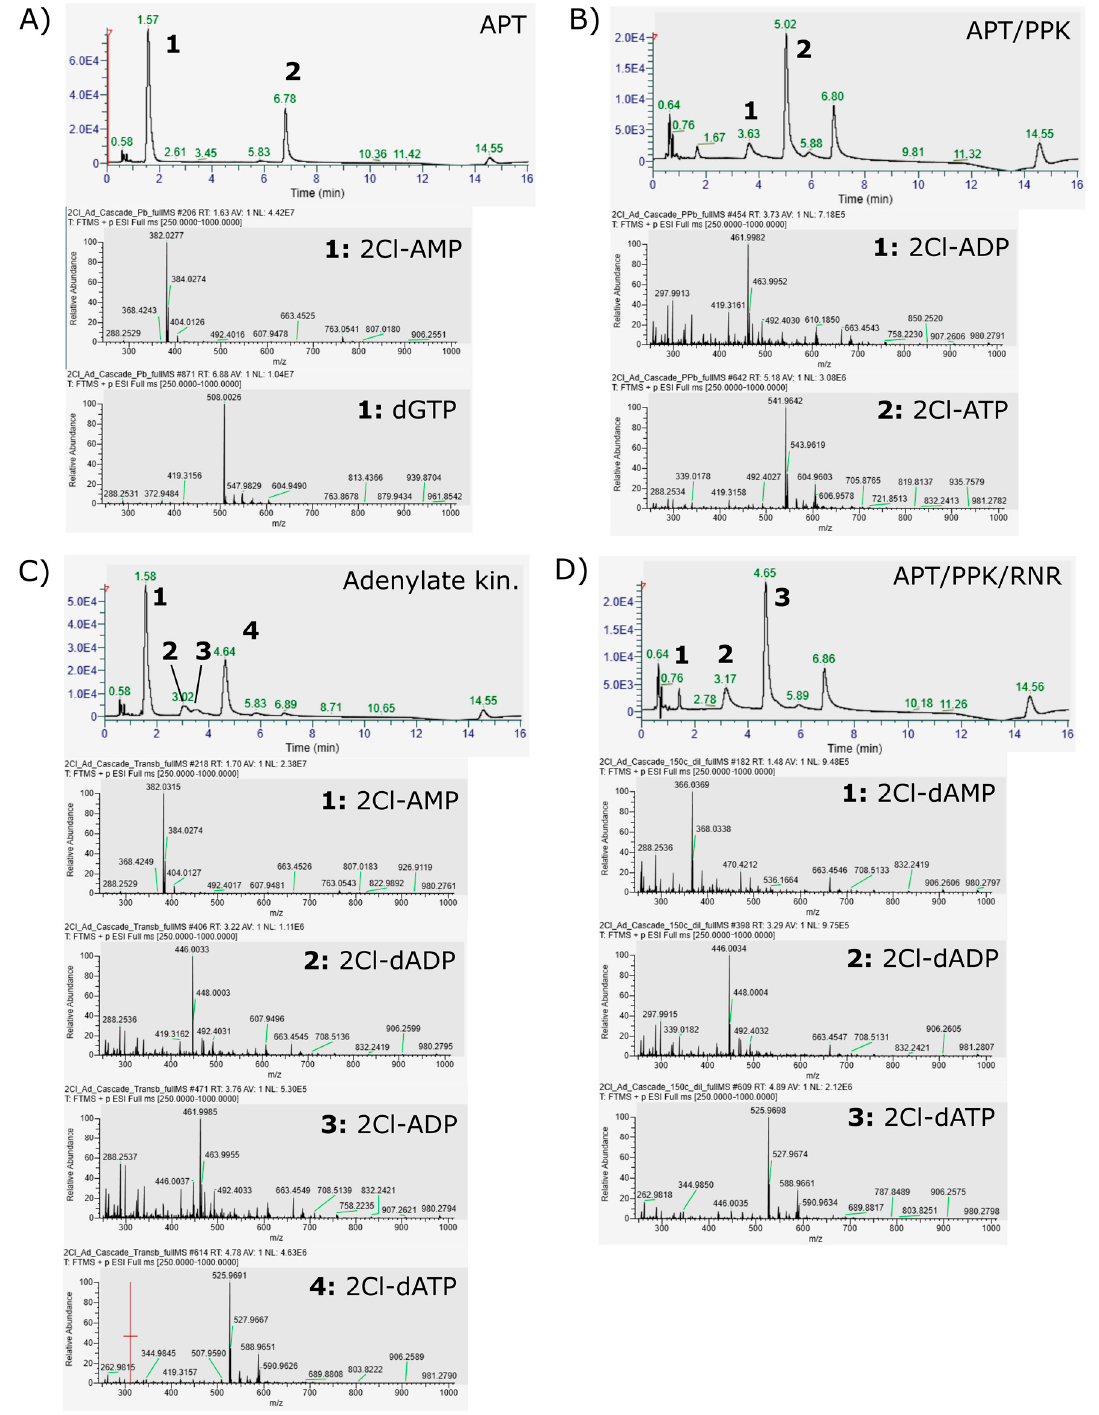
Figure A3. LC-MS identification of 2Cl-adenosine (deoxy)ribonucleotides: ( A ) LC and full-MS spectra of the reaction of APT only with 2Cl-adenine as substrate. Identified peaks: 1: 1.57 min, 2Cl-AMP; 2: 5.78 min, dGTP. ( B ) LC and full-MS spectra of the reaction of APT and PPK with 2Cl-adenine as substrate. Identified peaks: 1: 3.63 min, 2Cl-ADP; 2: 5.02 min, 2Cl-ATP. ( C ) LC and full-MS spectra of the adenylate kinase test reaction of APT and PPK with 2Cl-adenine as substrate and 2Cl-dATP as phosphate donor. Identified peaks: 1: 1.58 min, 2Cl-AMP; 2: 3.02 min, 2Cl-dADP. 3.51 min, 2Cl-ADP; 4.64 min. 2CL-dATP. ( D ) LC and full-MS spectra of the Reaction of the full cascade with 2Cl-adenine as substrate. Identified peaks as 1: 1.48 min, 2Cl-dAMP; 2: 3.17 min, 2Cl-dADP; 3: 4.65 min,